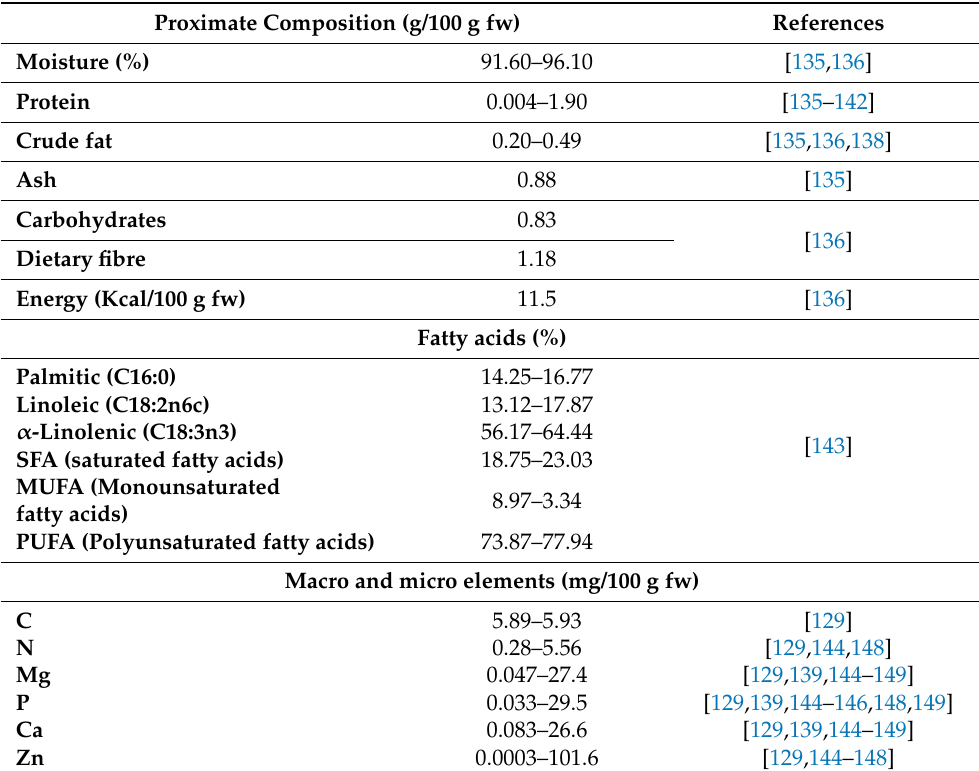
Table 5. Energetic value, proximate composition, and free sugars of Lactuca sativa L. Proximate Composition (g/100 g